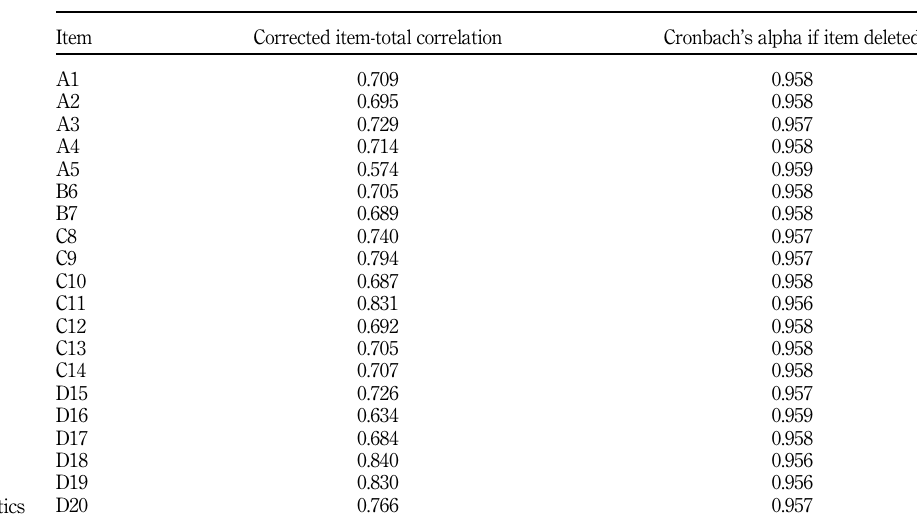
Table 3. Total items